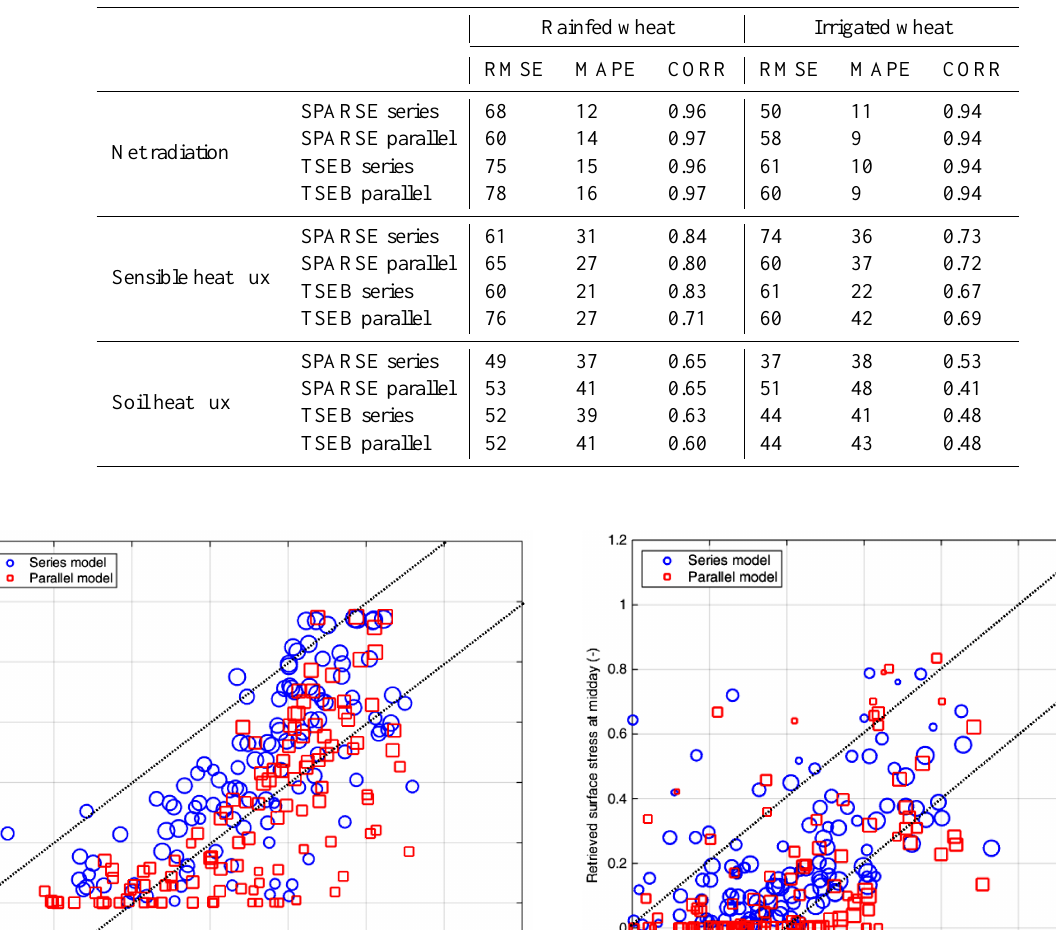
Table 2. Performances of instantaneous retrievals at midday for net radiation, total sensible heat flux and soil heat flux (RMSE: root mean square error in Wm − 2 ; MAPE: mean absolute percentage error in %; CORR: correlation coefficient).